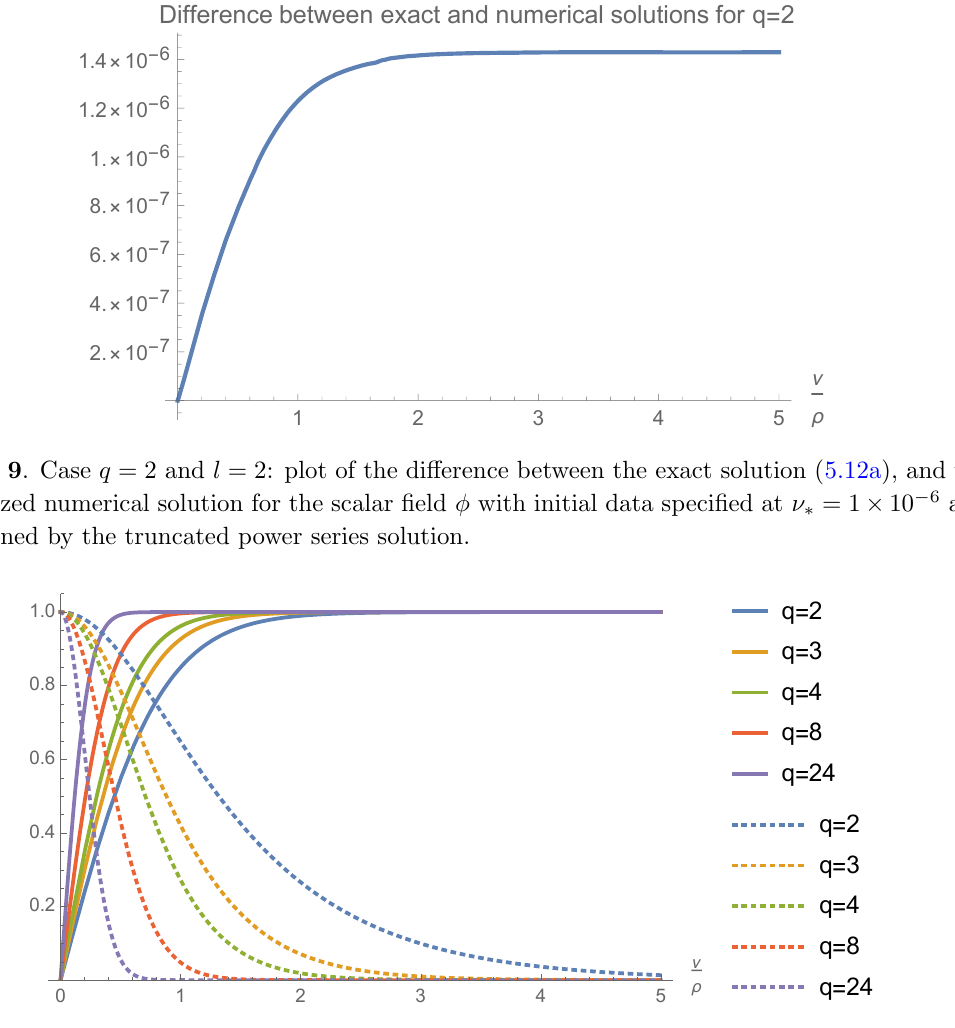
Figure 10 . Plots of the (cid:30) and h (cid:12)elds in the vortex case l = 2 for various values of q . The (cid:30) (cid:12)elds are the solid curves, and the h (cid:12)elds are the dotted curves. Remember that the h solution is exact, and (cid:30) is obtained numerically. The (cid:30) numerical solutions are normalized to the correct behavior at (cid:23) = 1